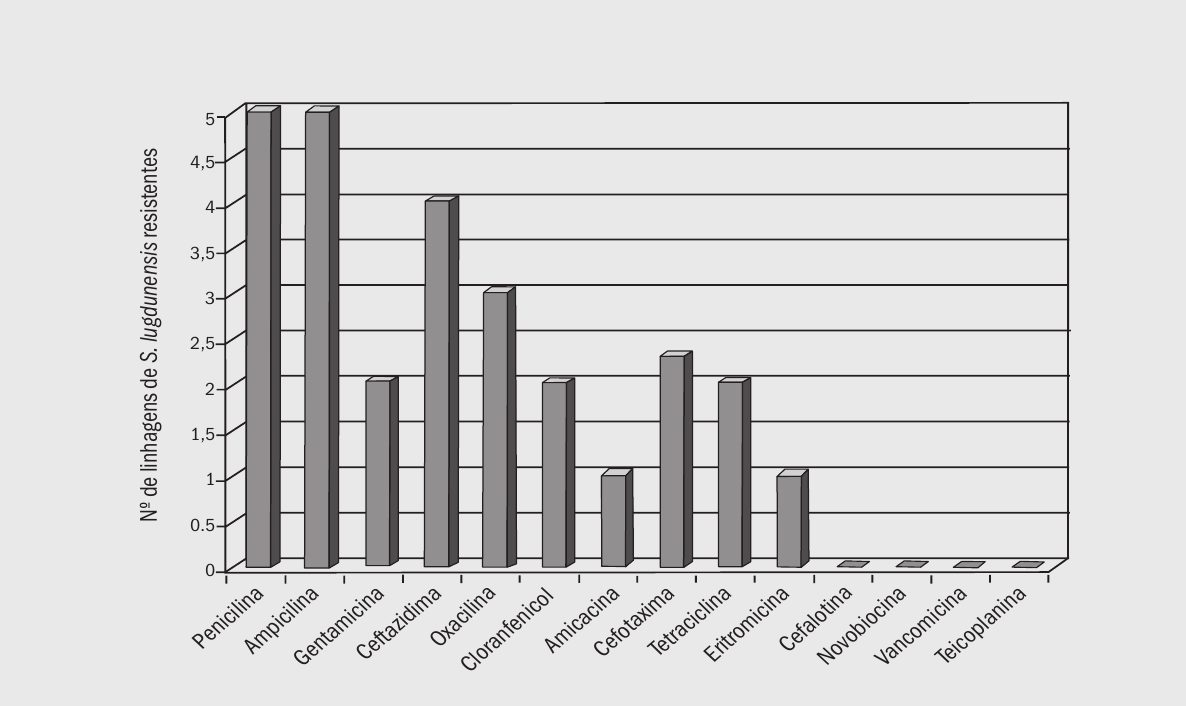
Figura 5 – Resistência às drogas apresentada pelas linhagens de S.